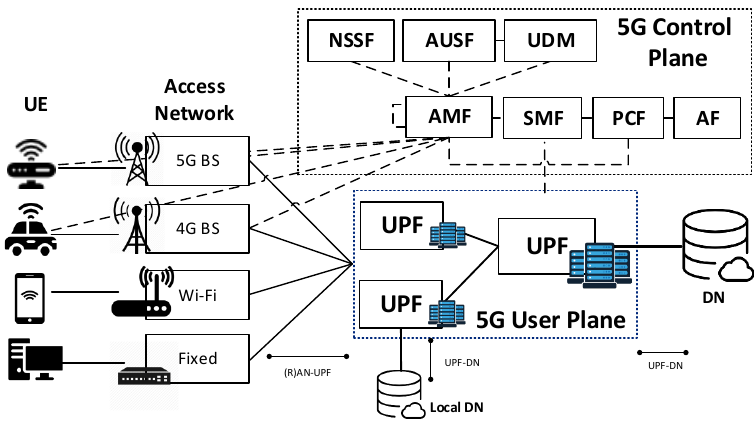
Figure 1. 5G architecture based on